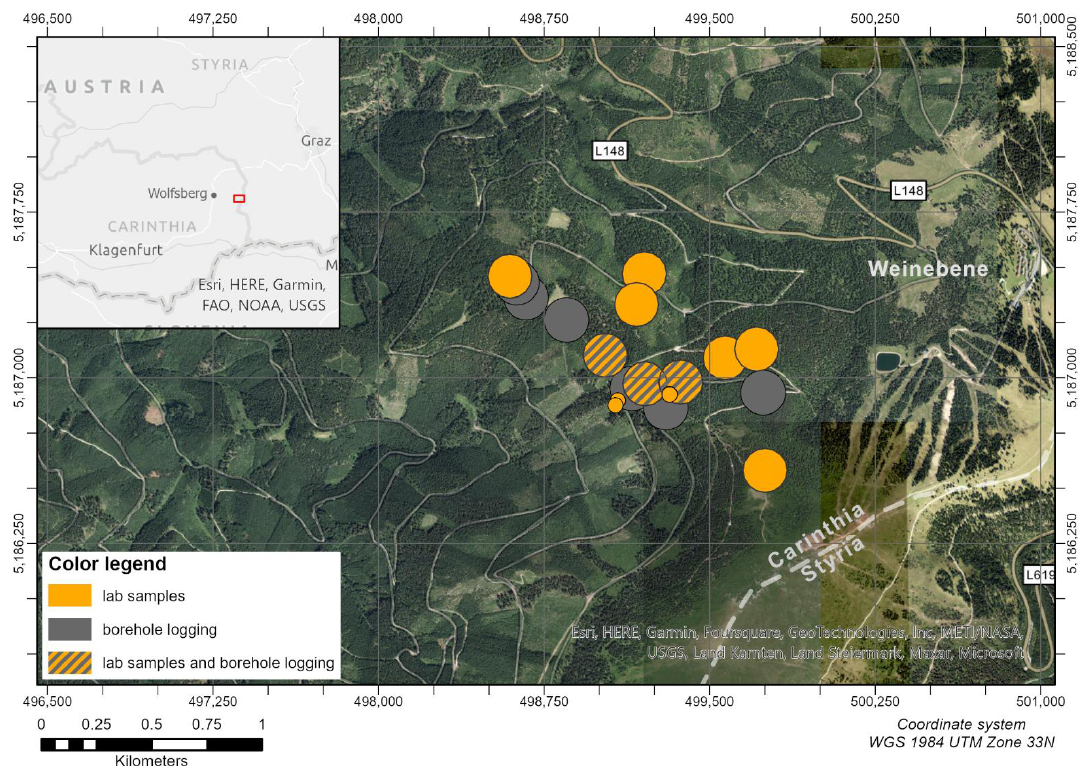
Figure 2. Sample locations from the Austrian site in Wolfsberg. Small circles indicate the locations of field samples from the mine. Large circles indicate the approximate locations of the confidential boreholes. The red frame in the inset map outlines the location map.